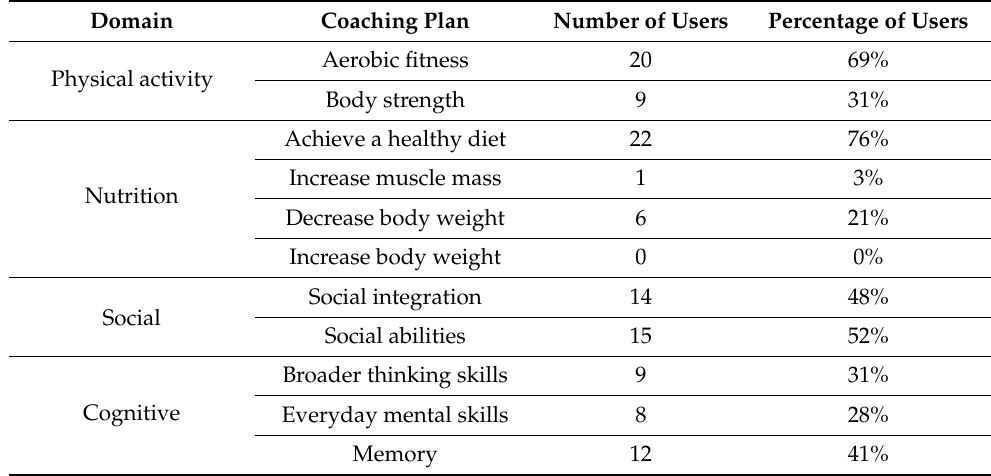
Table 3. Pathway choices (coaching plans in each domain) for the 29 pilot users who started the intervention